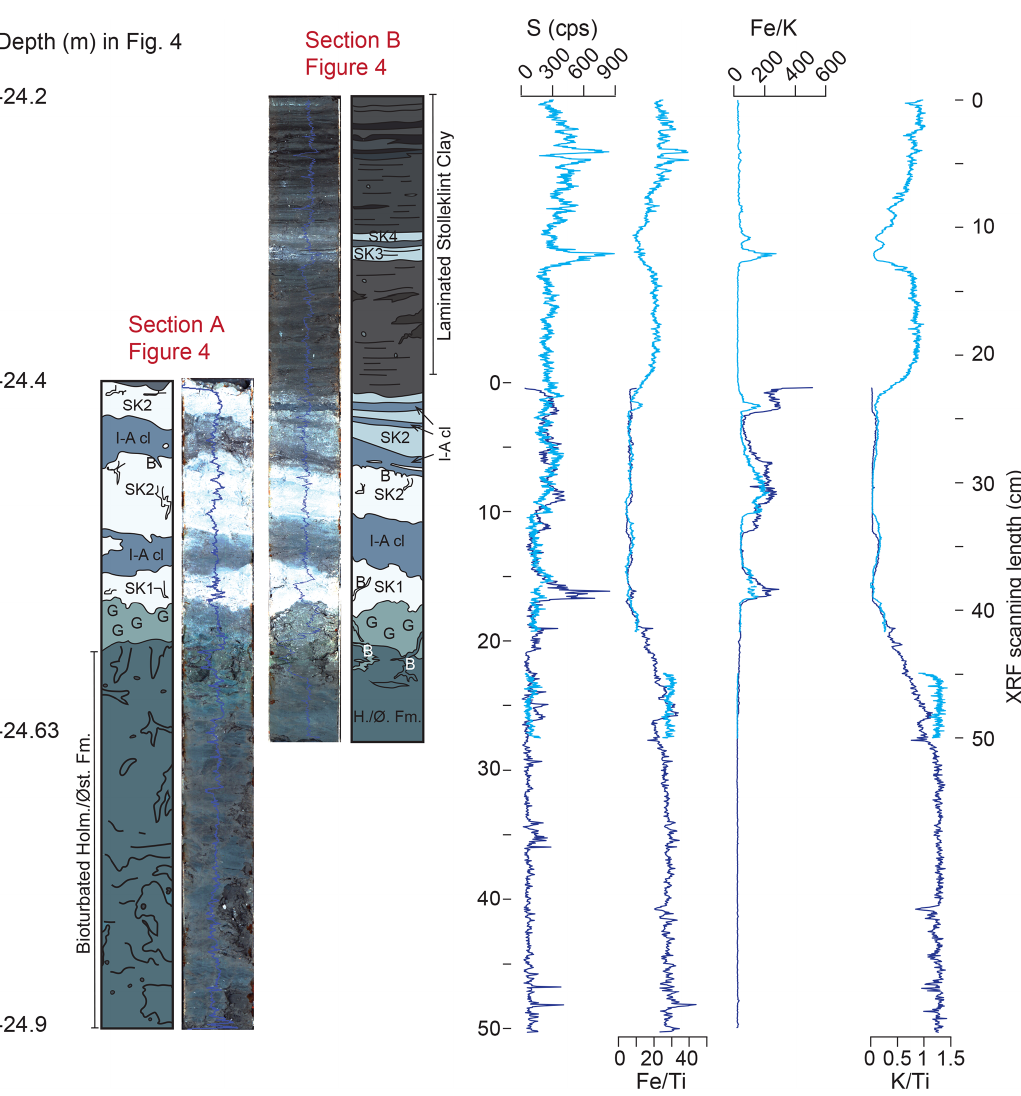
Figure 5. XRF element core scans and radiographic images of two box cores crossing the PETM onset at the Stolleklint beach. Note that despite some cracks in the surface below Ash SK1, the sample preservation is overall good and XRF core scanning were conducted on a smoothed surface along the centre avoiding any substantial irregularities. Interpretive logs next to the images indicate the lithological changes. G: glauconite; B: burrow; I-A cl: inter-ash clay. The corrected stratigraphic depth relative to Ash − 33 of each section is indicated on the left. XRF scanning length seen on the right indicate actual box-core length. XRF data are given as counts per second (cps) or as dimensionless